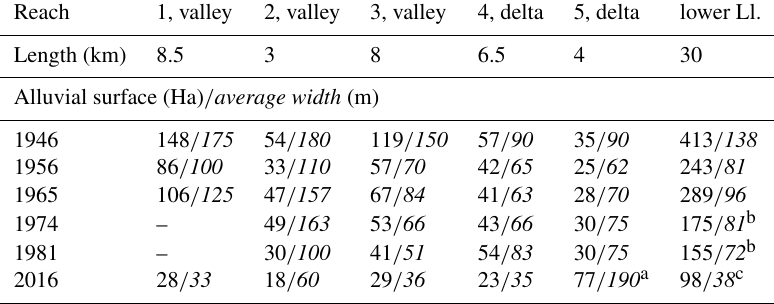
Table 4. Alluvial surfaces and average widths of the strictly speaking alluvium in the aerial photographs. For an example see Fig. 6 (Prats- Puntí, 2018). Reach 1, valley 2,